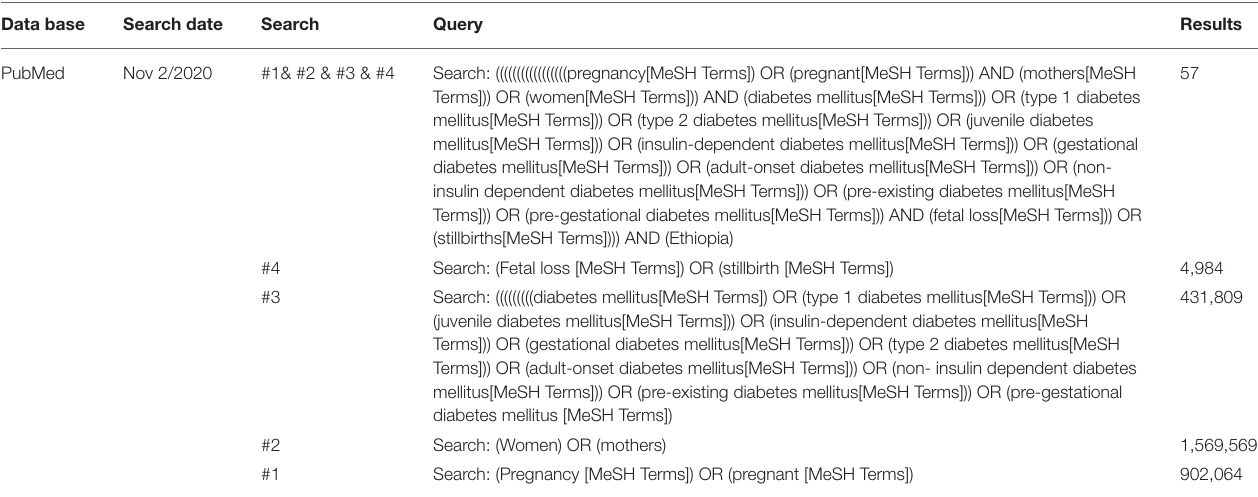
TABLE 1 | Search strategy for PubMed data